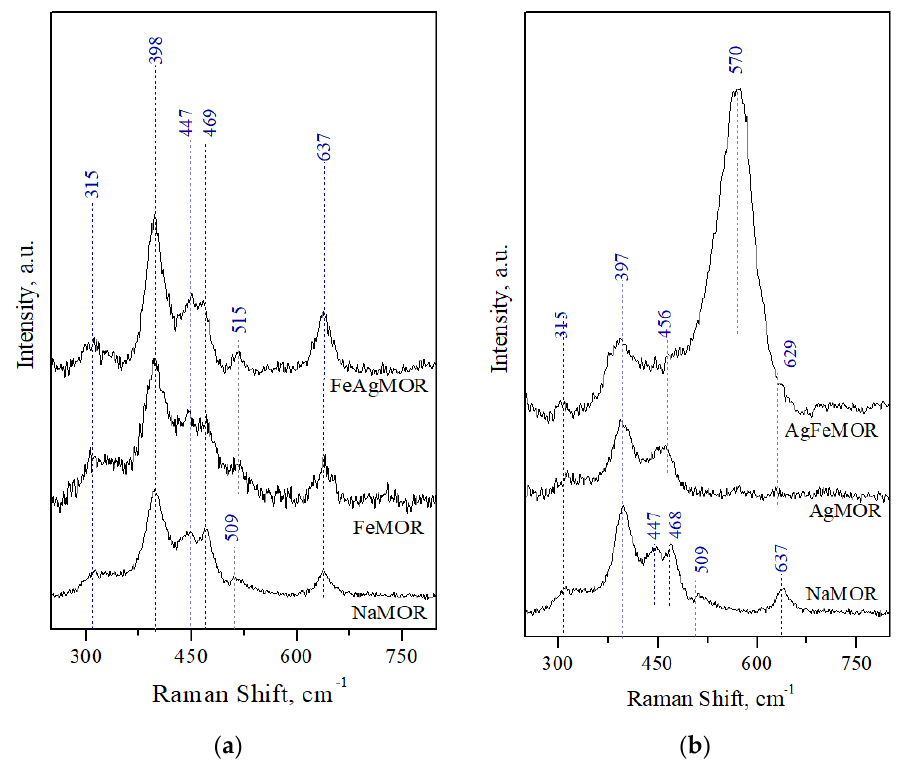
Figure 6. Normalized micro-Raman spectra exited by a 784.29 nm laser line for ( a ) NaMOR, FeMOR and FeAgMOR; ( b ) NaMOR, AAgMOR and AgFeMOR.